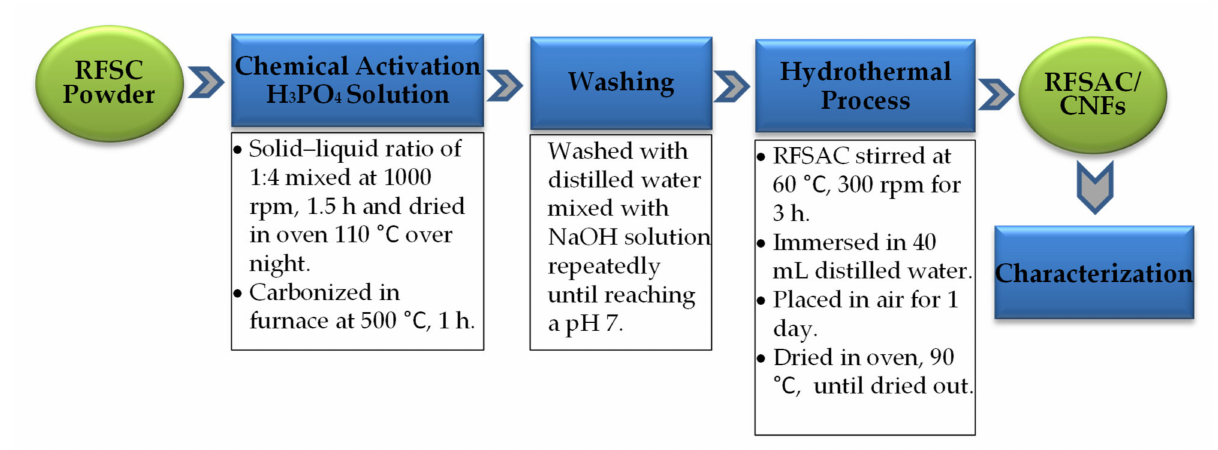
Figure 2. The chemical activation and hydrothermal